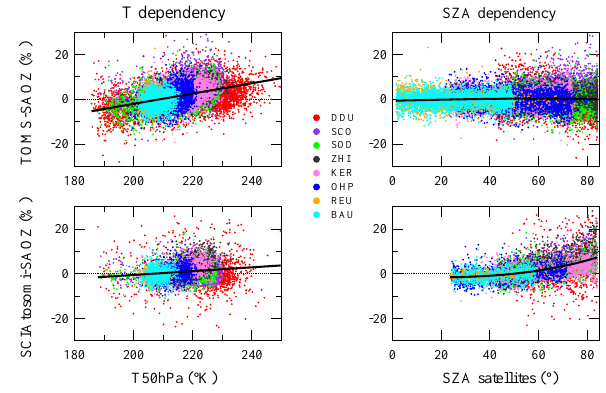
Table 8. SZA dependence of satellite-SAOZ V2 relative difference at 50hPa: b × SZA + c × SZA 3 . Fig. 12. Correlation between daily satellite-SAOZ difference and ECMWF temperature at 50hPa (left), and SZA of satellite measure- ments (right) for the height SAOZ stations altogether. Top: TOMS; Bottom: